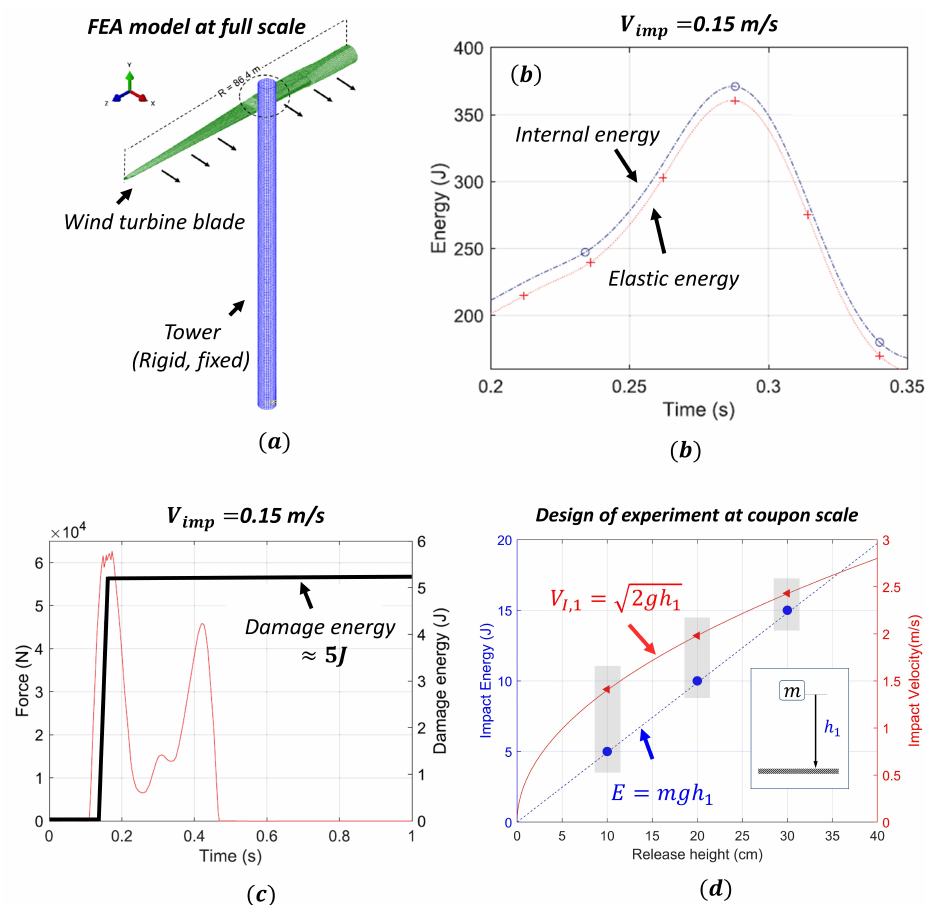
Figure 5. ( a ) Full scale Finite Element Model (FEA) model from [2], ( b ) comparison of internal energy and elastic energy in the blade [2], ( c ) magnitude of damage energy developed in full scale blade [2], and ( d ) coupon scale impact